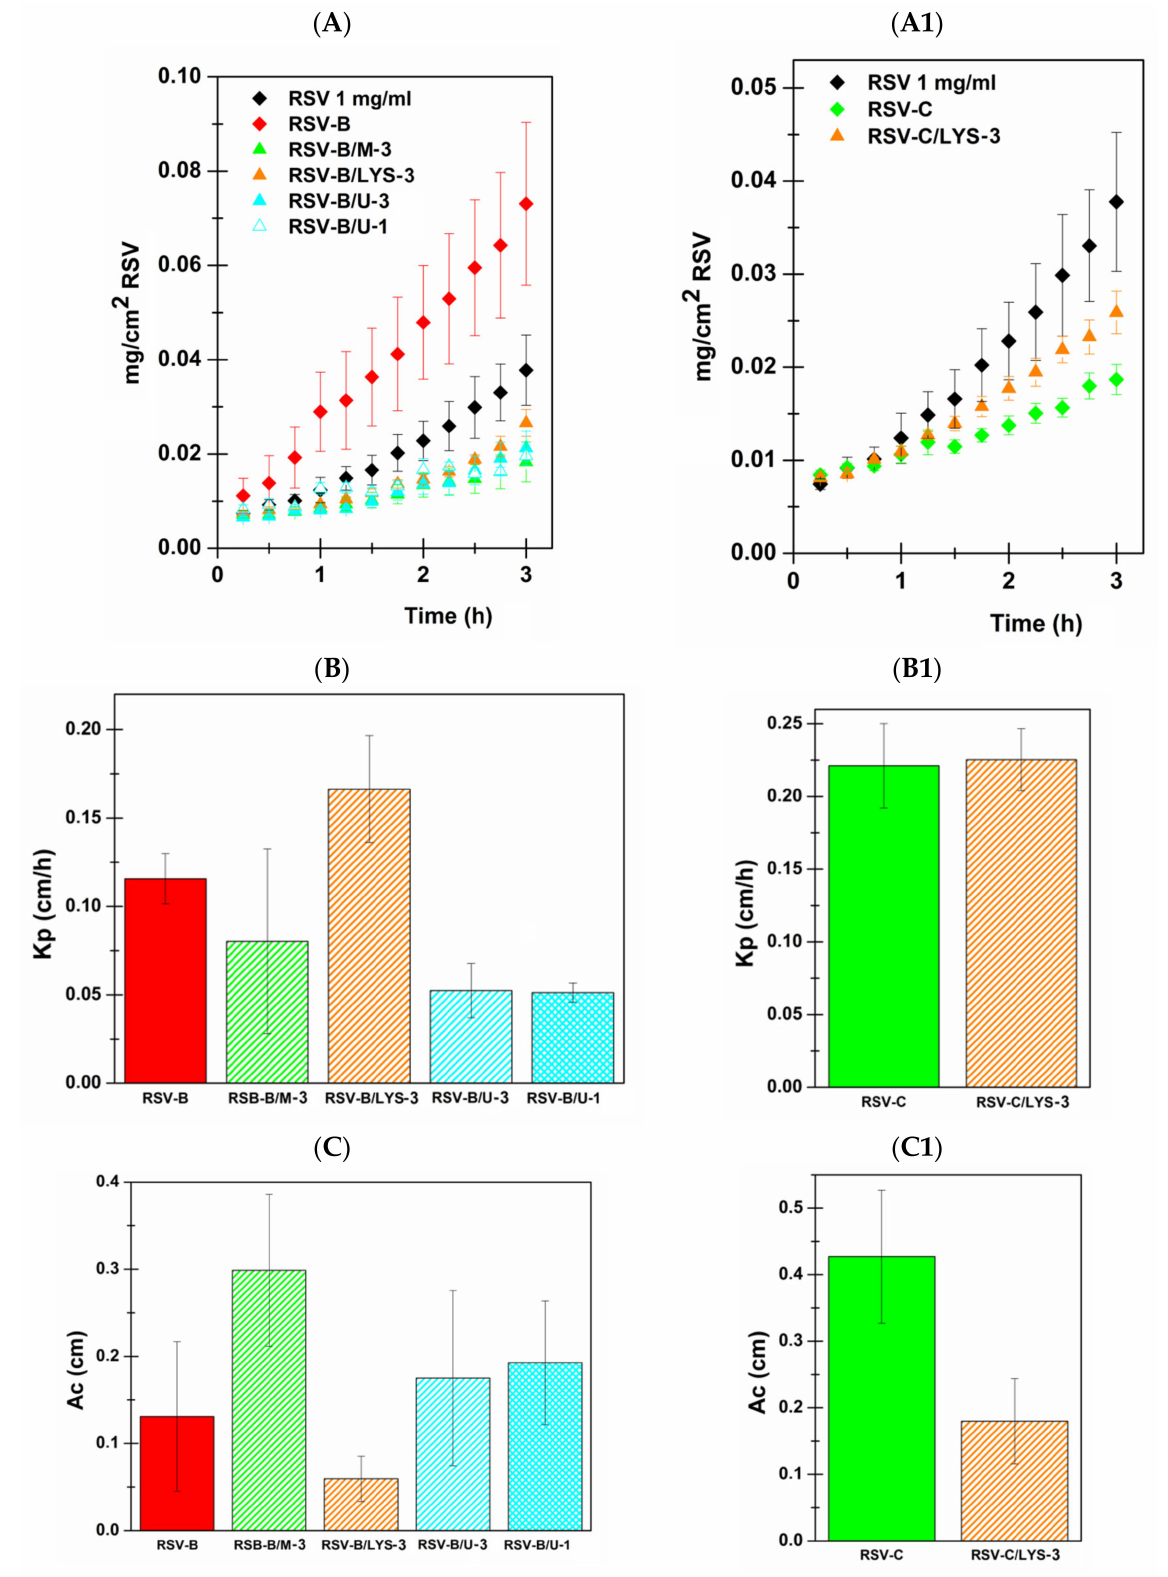
Figure 5. ( A , A1 ): Amount of RSV (mg/cm 2 ) permeated from mini-tablets as a function of time (h). ( B , B1 ): Kp; ( C , C1 ) Ac parameters calculated after administration of RSV solution 1 mg/mL (black), RSV-B mini tablet vs. CPE-loaded RSV-B ( A – C ) and RSV-C mini tablet vs CPE-loaded RSV-C ( A1 – C1 ). Results are presented as means ± SE ( n =